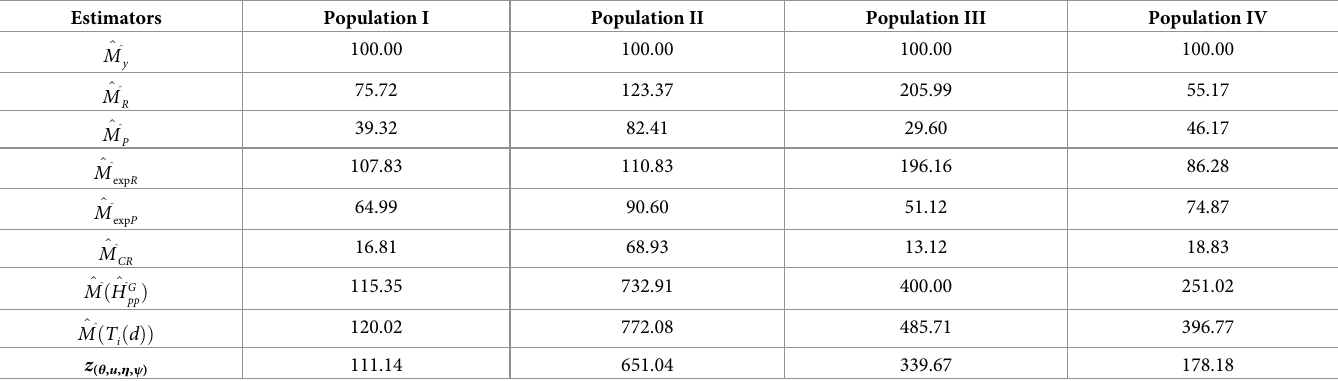
Table 6. PREs of the members of the proposed class of